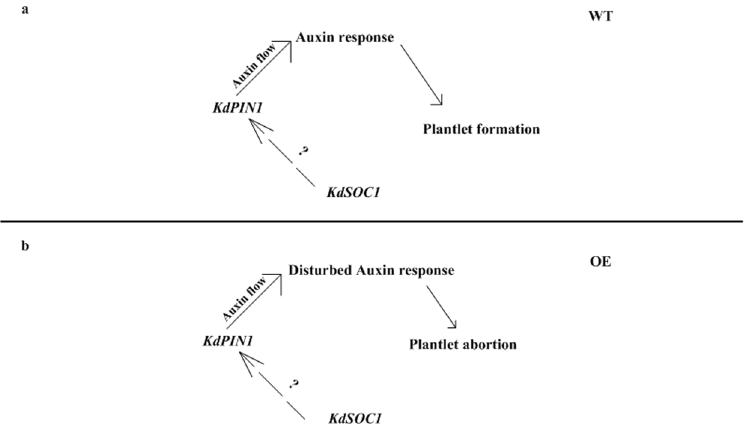
Figure 8. Putative model of KdSCOC1 gene mediated plantlet morphogenesis. ( a ) Plantlet morphogenesis in WT plant. ( b ) Plantlet morphogenesis in KdSOC1 gene OE plant. Green arrow indicated auxin flow and green represented the maximum auxin